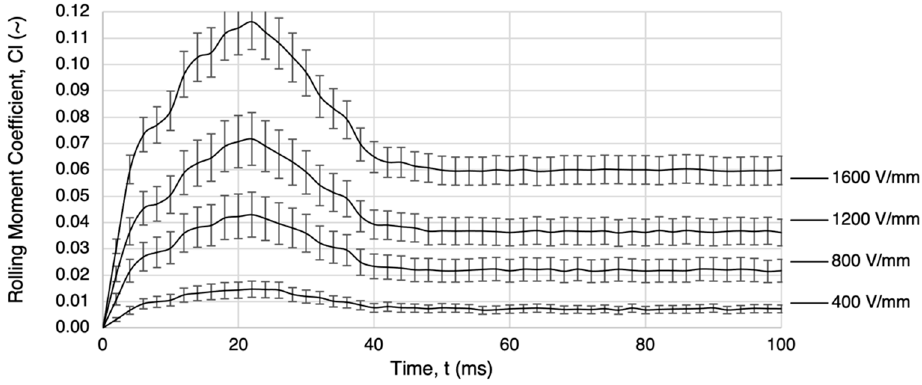
Figure 16. Rolling moment coefficient about the wing root, 120 ft/s (36.6 m/s), Rn = 191,000.